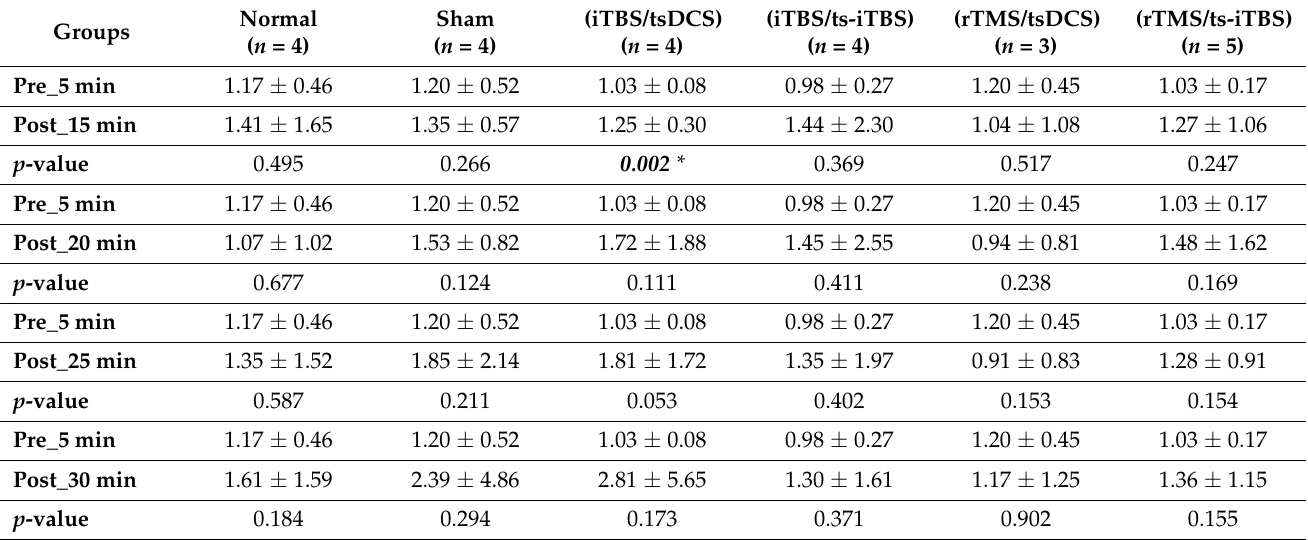
each group. The level of significance was set to p < 0.050 *.